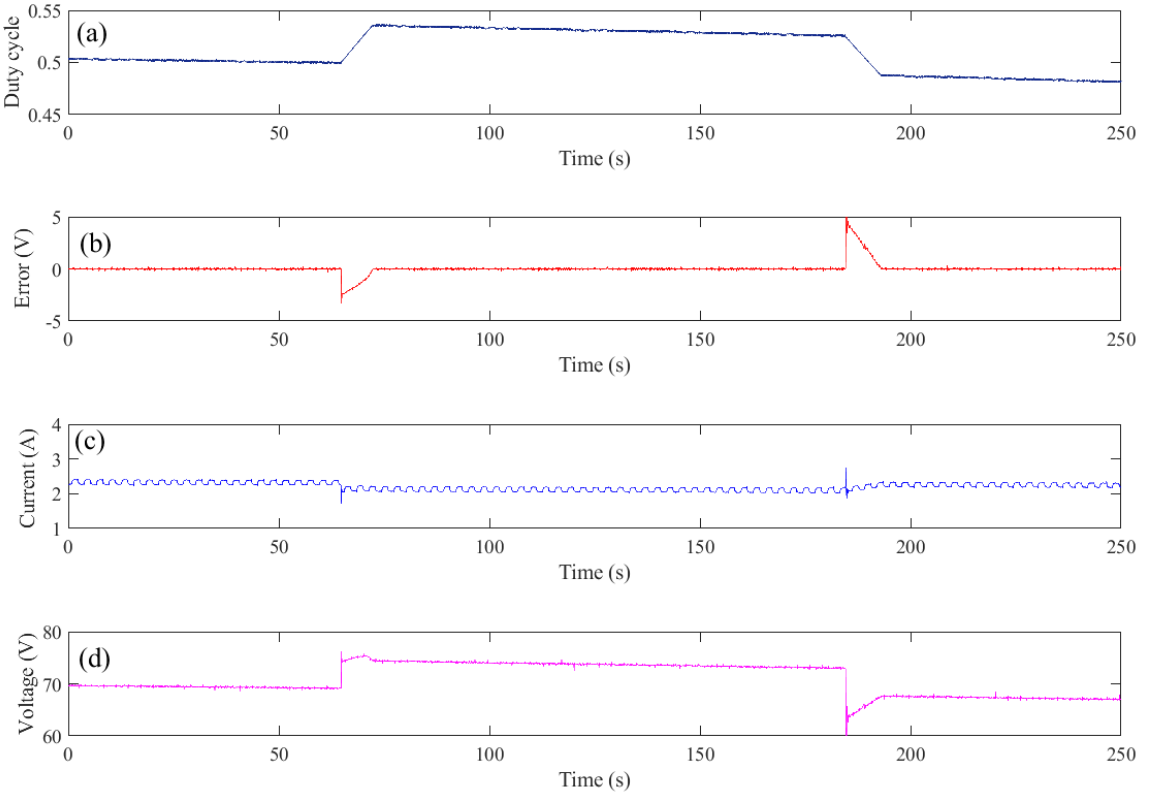
Figure 20. MPPT based on RNN and FLC: ( a ) Load Resistance ( V out / I out ); ( b ) PV current; ( c ) PV voltage; ( d ) PV power.